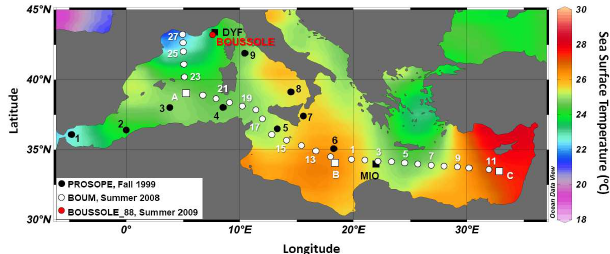
Fig. 1. False-color composite satellite image of sea surface tem- perature of the Mediterranean Sea in July 2008 (data: NOAA). The sampling stations of the PROSOPE, BOUM and BOUSSOLE 88 cruises, numbered in order of occupation, are indicated in black, white and red, respectively. Short- and long-term stations are indi- cated by dots and squares,